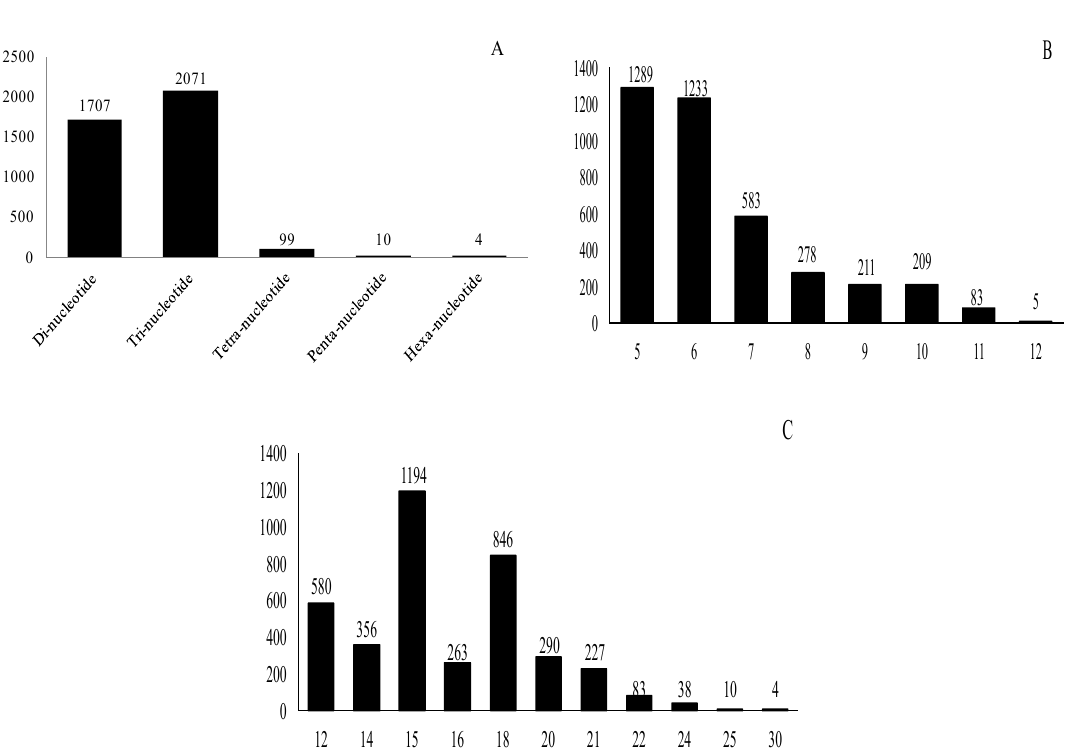
Figure 6. Frequency distribution of the Gynostemma expressed sequence tag (EST)-SSRs of different sizes. ( A ) Unit size; ( B ) Number of repeats; ( C ) SSR locus length. Table 4. Frequency distribution of the di- and tri-nucleotide repeat motifs in the Gynostemma. Serial